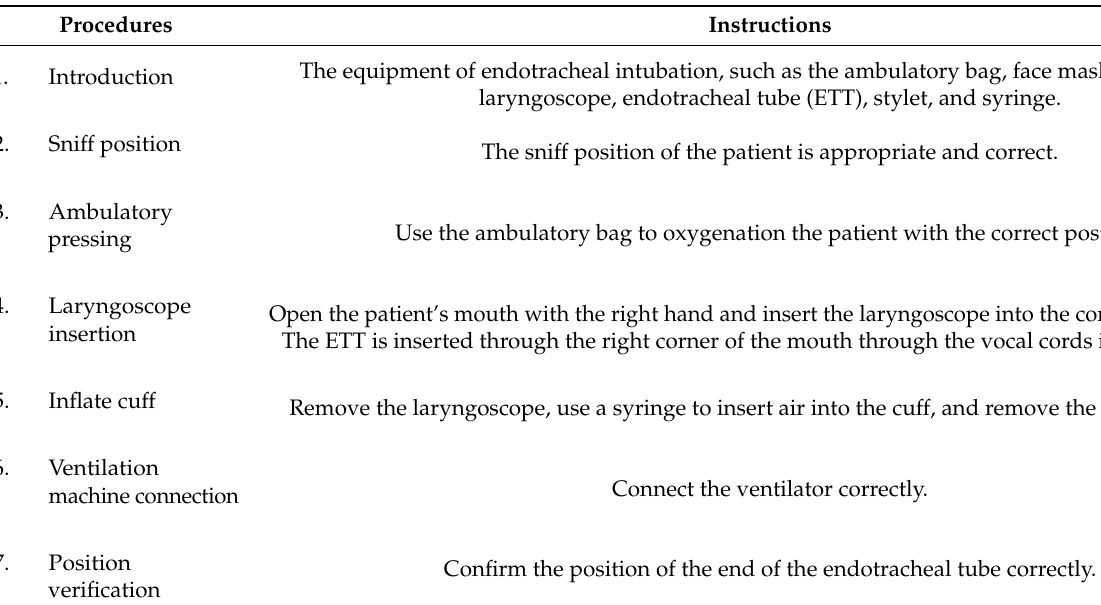
Table 2. The instructions of each procedure in VR intubation training.